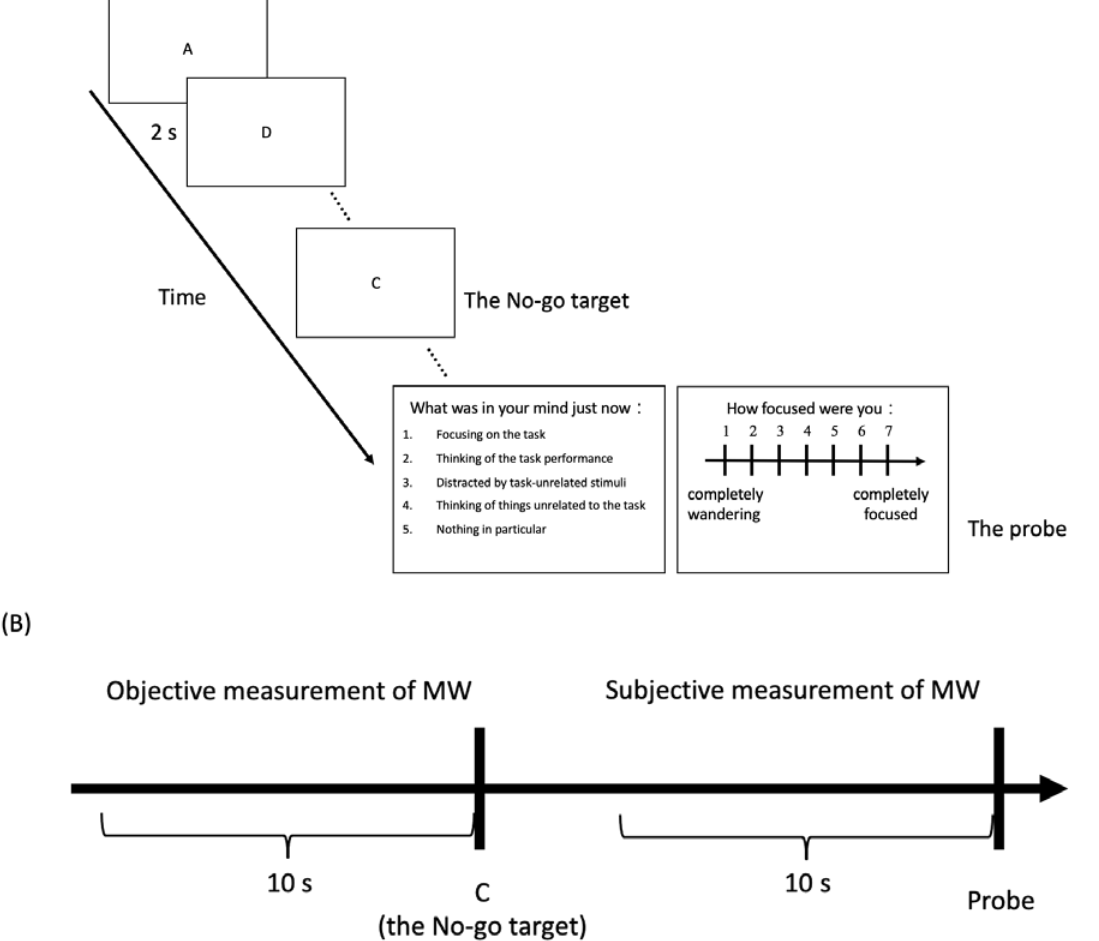
Figure 1. ( A ) Experimental procedure of the SART (the actual background color was grey). Participants were instructed to press the number 8 on the number-pad as quickly as possible whenever they saw an English letter but to withhold their response when they saw the target letter C. After 25 trials (at the end of a block), participants were instructed to answer the two probe questions. ( B ) The analyzed time windows of the SART. The objective measurement of MW was analyzed in the time window 10 s before the English letter C (i.e., the No-go target); the subjective measurement of MW was analyzed in the time window 10 s before the probe.